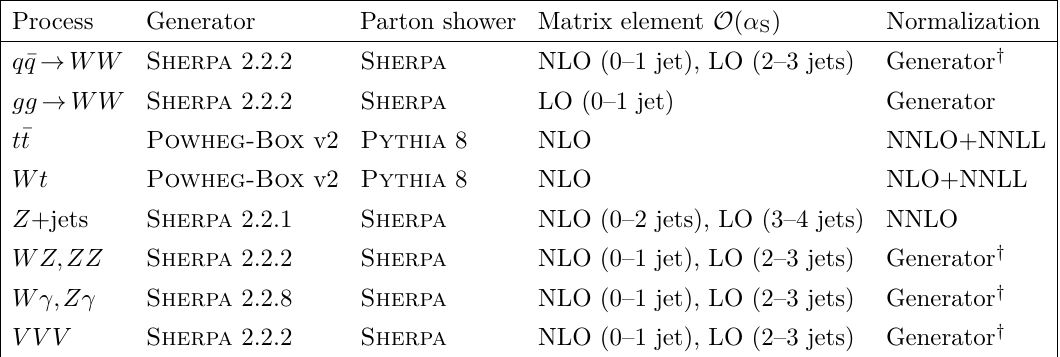
Table 1 . Summary of the nominal Monte Carlo simulated samples used in the analysis. The gg → WW simulation includes Higgs boson contributions. The last two columns give the order in α of the matrix element calculation and the overall cross-section normalization. All nominal S MC samples use the NNPDF3.0 PDF set. The samples generated with Sherpa use the default set of tuned parton-shower parameters, while for the Powheg-Box samples the A14 set of tuned parameters and the NNPDF2.3LO PDF set are used for the parton